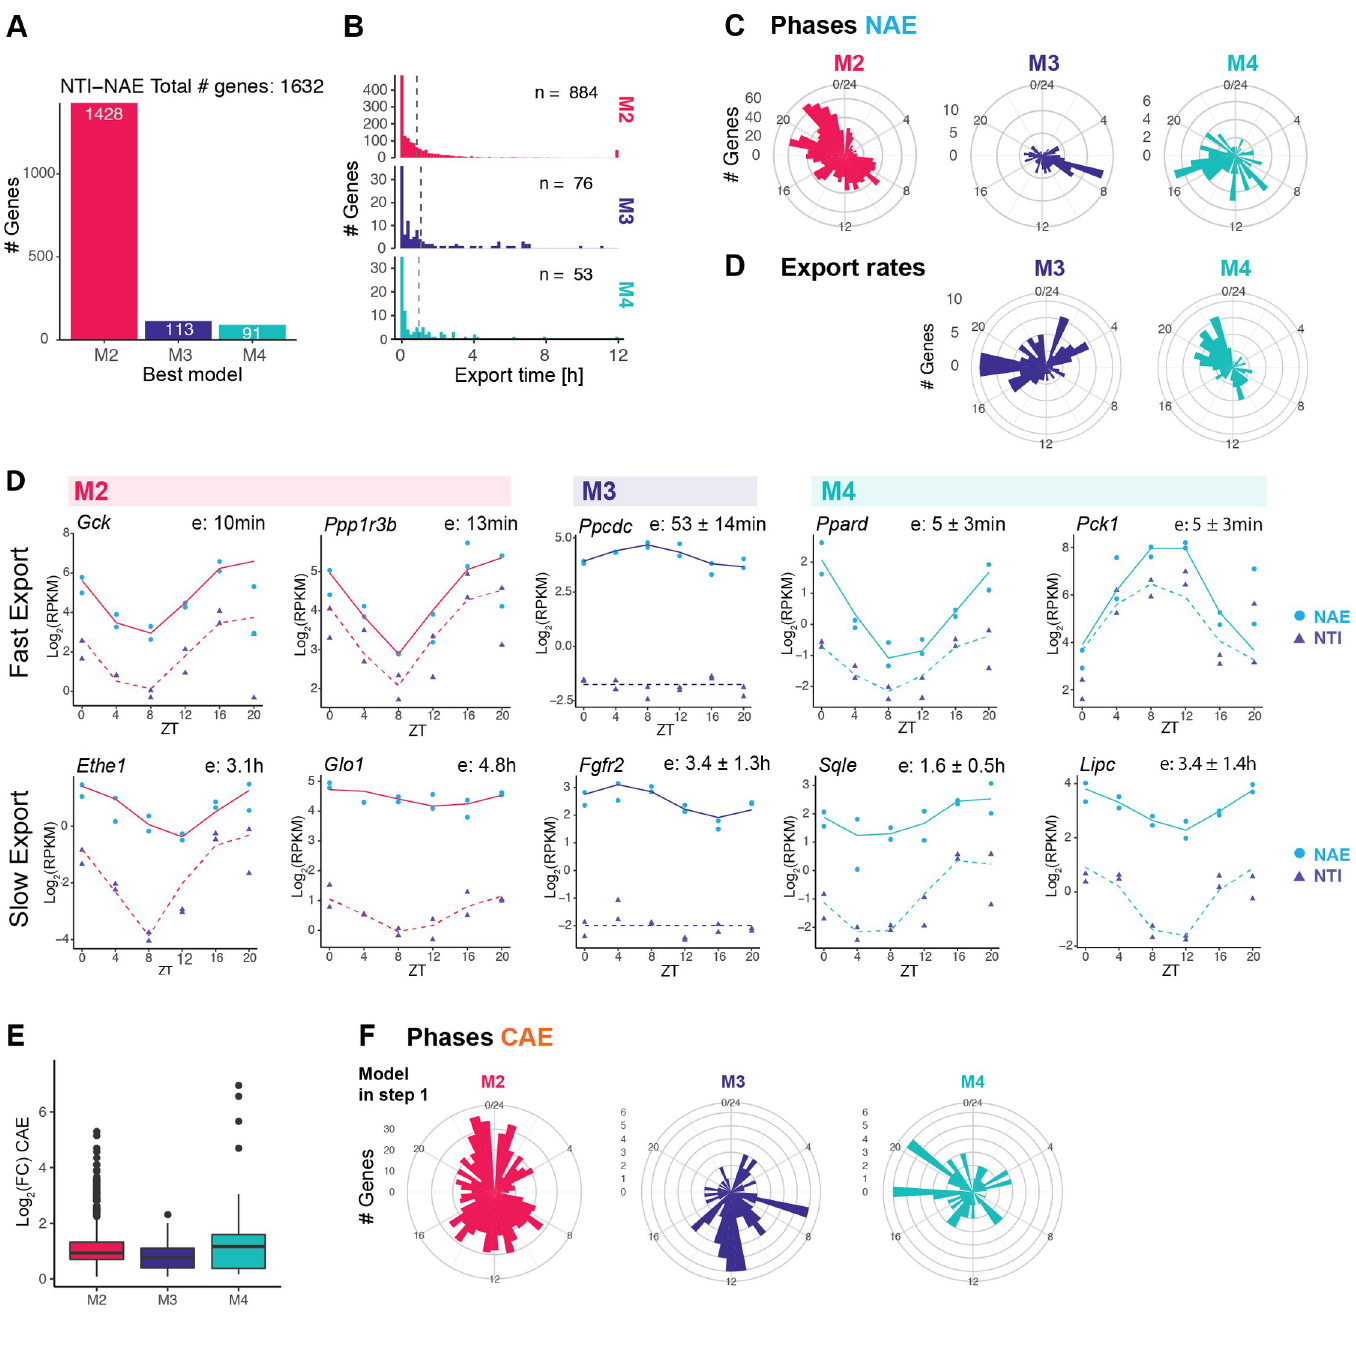
Fig 5. Kinetic model identifies rhythmically exported nuclear mRNAs. A : Classification of genes in M2 (rhythmic transcription, constant export), M3 genes (constant transcription, rhythmic export), or M4 (rhythmic transcription, rhythmic export). B : Distribution of estimated export times of the three models. The median (dotted line) is calculated excluding export times reaching the lower or upper boundary (5 min and 12 h). C : Distribution of peak times of rhythmic nuclear mRNA (NAE). C : Distribution of peak time of rhythmic export rates (shortest export time) of M3 and M4 (in M2, export is constant). D : Representative temporal profiles of nuclear pre- mRNA (NTI) and nuclear polyadenylated mRNA (NAE) in M2, M3 and M4 genes with short export time (up) or long export time (bottom). Additional examples of M3 genes are shown in S2 Fig. E : Cytoplasmic mRNA fold-change of genes classified as M2, M3 or M3 in step1. F: distribution of phases in the cytoplasm of genes classified as M2, M3 or M4 at step